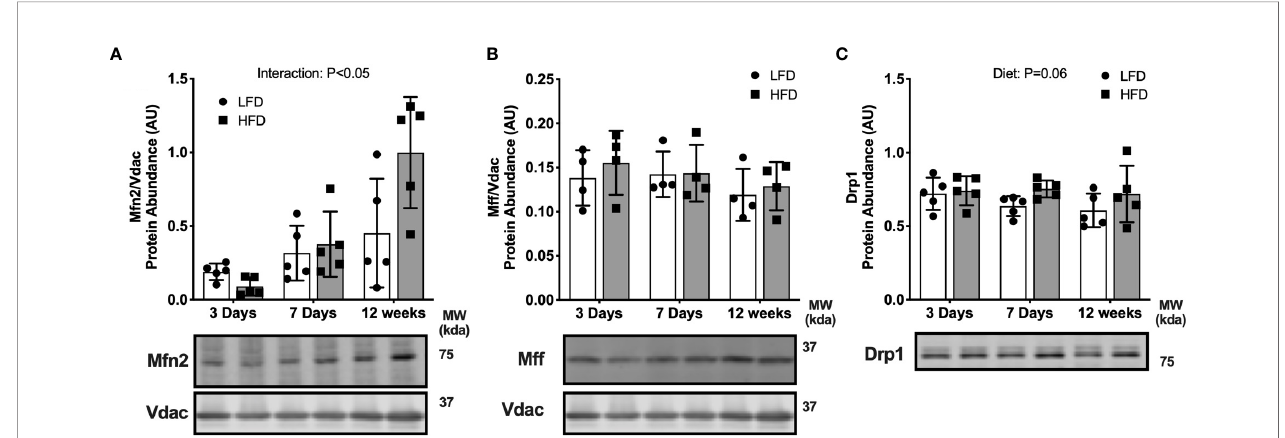
FIGURE 4 | Short-term high-fat feeding altered fusion marker Mfn2. Fusion and fi ssion markers in skeletal muscle of mice fed low-fat diet or high-fat diet for 3 days, 7 days, or 12 weeks. Quadriceps muscles were prepped as whole tissue lysates for immunoblotting. Gastrocnemius muscles were fractionated to prepare a mitochondrial-enriched fraction for immunoblotting of Mitofusion 2 (Mfn2) (A) and mitochondrial fi ssion factor (Mff) (B) . Drp1 protein abundance in whole tissue lysate (C) . Images below graphs are representative blot images. Protein targets in the mitochondrial fraction are normalized to Vdac abundance as a mitochondrial protein control. Panels (A, B) contain the same Vdac image because the targets are from the same membrane. Data are means ± SD; n=4-5. Two-way ANOVA was used to test for effects of diet and time. P values are main